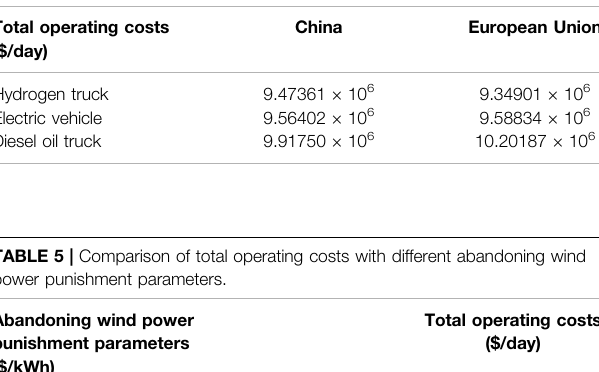
TABLE 4 | Comparison of total operating costs considering carbon emissions trading.